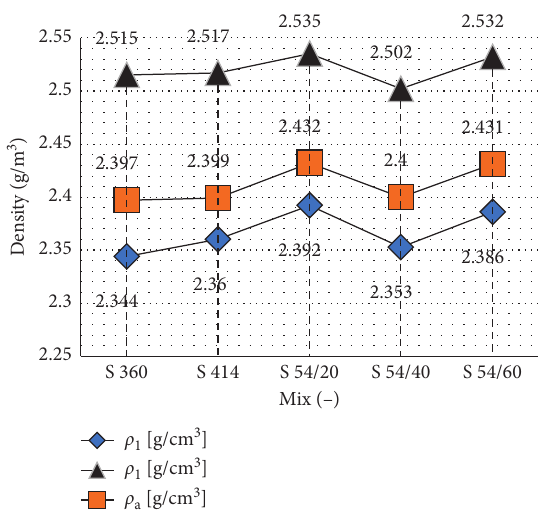
Figure 12: Density of mixtures (g/cm 3 ).